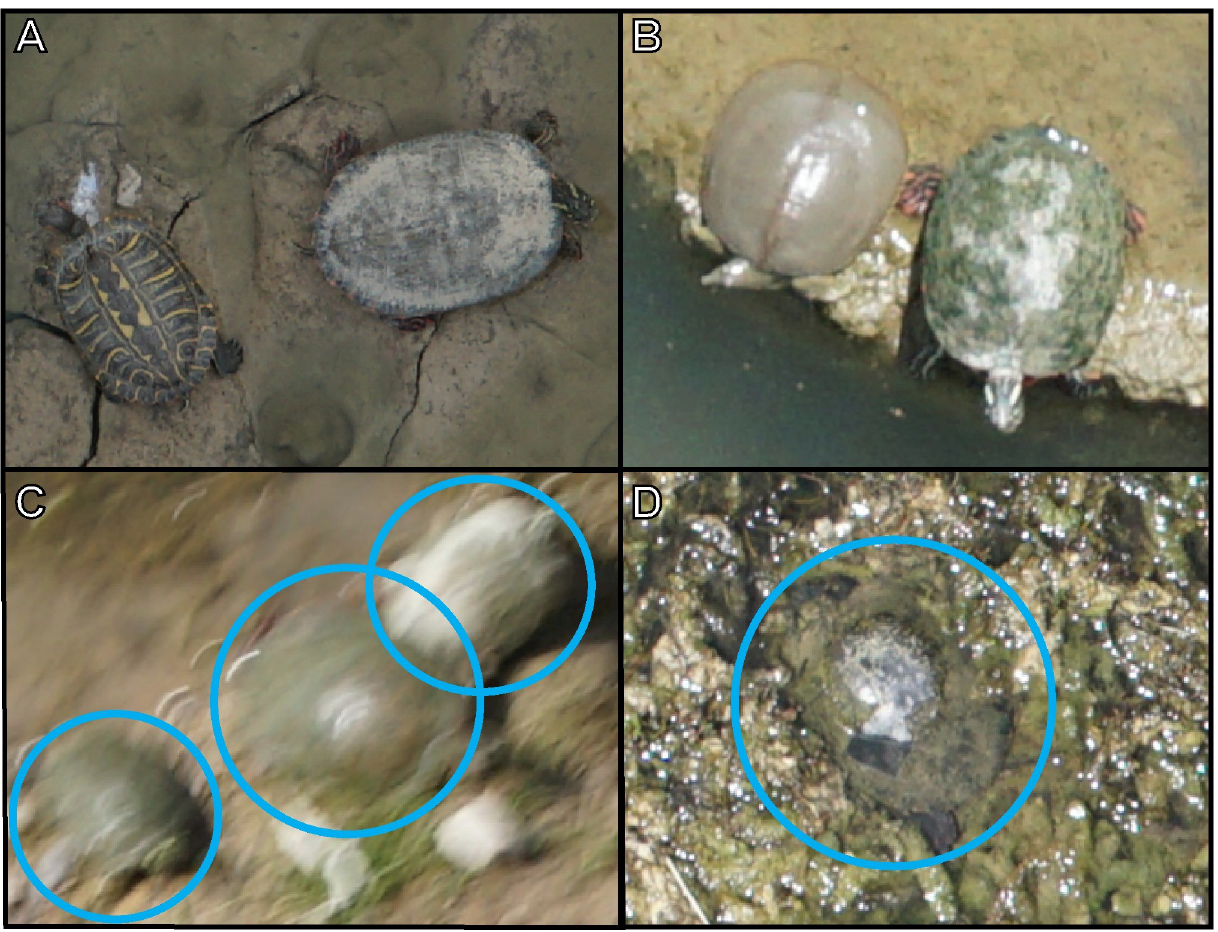
Fig 4. Magnified drone imagery of turtles. Magnified drone images depicting the species of turtles identified throughout this study and instances where turtles were unable to be identified. (A) Trachemys scripta elegans on left and Pseudemys gorzugi on right basking in the Rio Grande, near Saline ñ o, Starr County; (B) Apalone spinifera on left and P . gorzugi on right basking at the Eagle Pass Golf Course, spillway into Rio Grande, Maverick County; (C) out of focus, unidentified turtles (circles) basking at the Eagle Pass Golf Course, spillway into Rio Grande, Maverick County; (D) obscured, unidentified turtle (circle) at TNC Dolan Falls Preserve, Devils River, upstream of confluence with Dolan Creek.